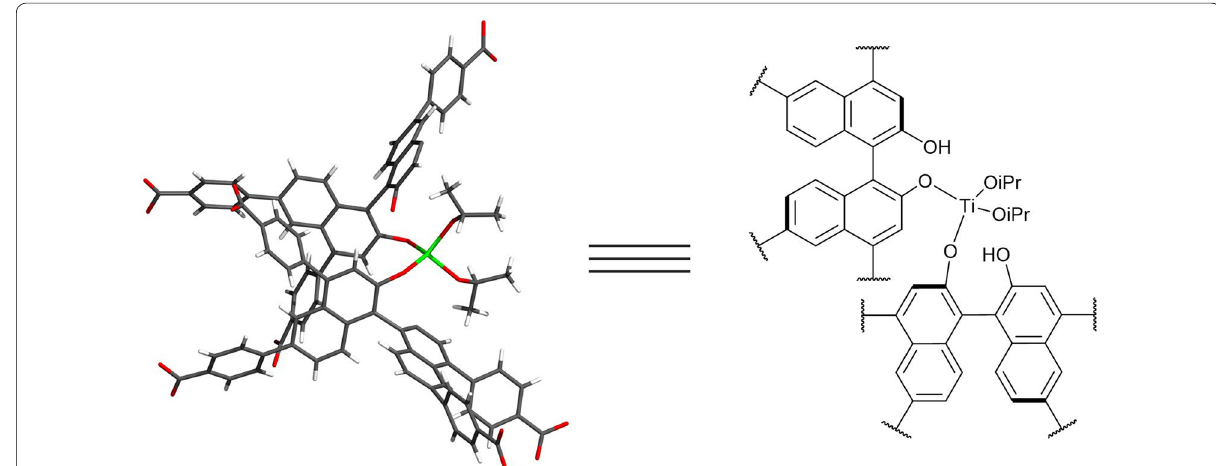
Fig. 5 Single crystal x-ray structure (left) and ChemDraw structure (right) of the intermolecular [(OiPr) 2 Ti(BINOLate) 2 ] species, where BINOL [1,1 ′ -binaphthalene]-2,2 ′ -diol, formed following the introduction of Ti(OiPr) 4 . This is the species responsible for causing the interpenetra- = tion of the two networks (Adapted with permission from Ref. [52]. Copyright 2010